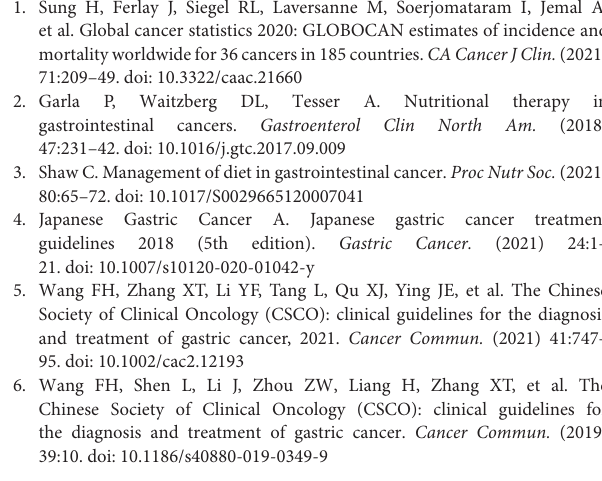
Supplementary Figure 1 | Risk of bias summary of studies included. Supplementary Figure 2 | Risk of bias graph of studies included. Supplementary Figure 3 | Funnel plot of meta-analysis of overall complications. Supplementary Figure 4 | Funnel plot of meta-analysis of infectious complications. Supplementary Table 1 | Characteristics of all studies included in the meta-analysis. Supplementary Table 2 | Analysis of gastric cancer outcomes. Supplementary Table 3 | Analysis of colorectal cancer outcomes. Supplementary Table 4 | Analysis of esophageal cancer outcomes. Supplementary Table 5 | Analysis of periampullary cancer (including pancreatic cancer) outcomes. Supplementary Table 6 | Analysis of preoperative nutrition outcomes. Supplementary Table 7 | Analysis of postoperative nutrition outcomes. Supplementary Table 8 | Analysis of standard diet as control groups. Supplementary Table 9 | Analysis of no supplement as control groups. Supplementary Table 10 | Analysis of malnourished patients outcomes. Supplementary Table 11 | Analysis of well-nourished patients